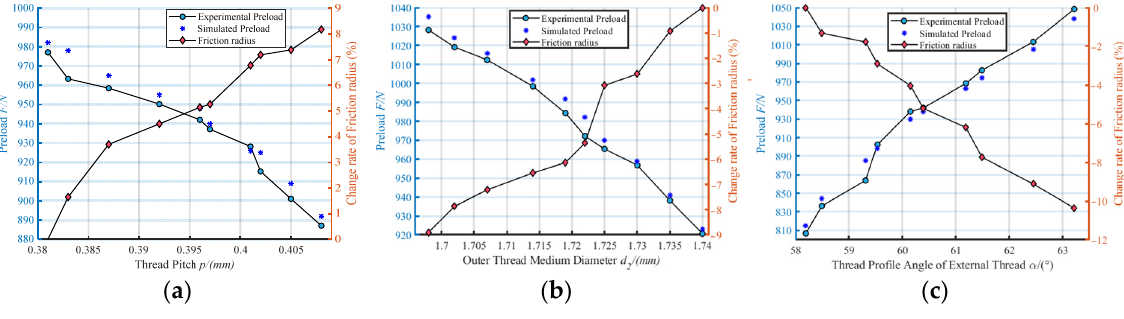
Figure 12. Changes of pre-tightening force and friction radius under the influence of pitch deviation ( a ), medium diameter of the thread deviation ( b ) and thread profile angle deviation ( c ).